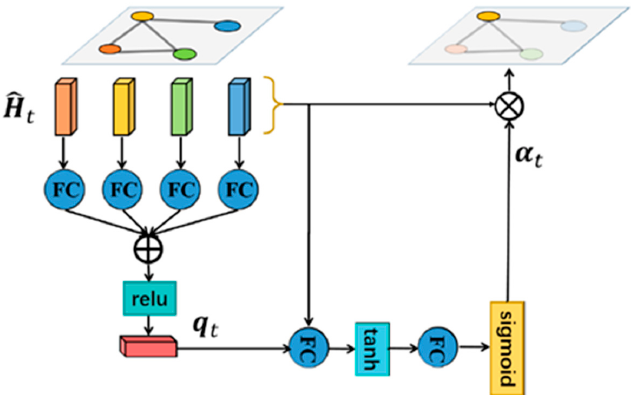
Figure 3. Illustration of the spatial attention mechanism